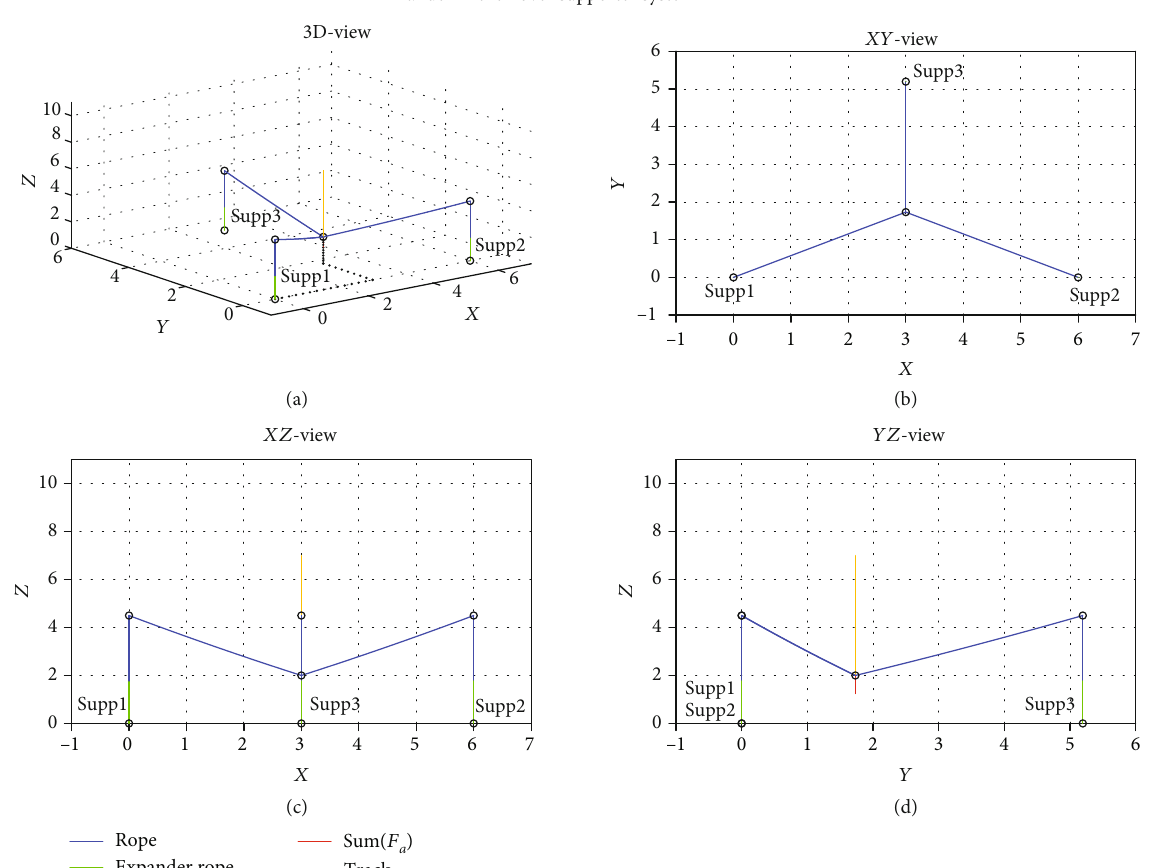
Figure 10: EAGLE ’ s trajectory 2 (in yellow) and the three ropes ( fi xed at the lander and led to the supporters). (a) 3D view of the motion. (b) XY view of the motion of EAGLE, in this plane reduced to a point. (c) XZ view of the motion of EAGLE: the overall force to be compensated for is constantly pointing upwards or downwards. (d) YZ view of the motion of EAGLE, where again the ropes generate a vertical pulling force on EAGLE, as visible from the Z component